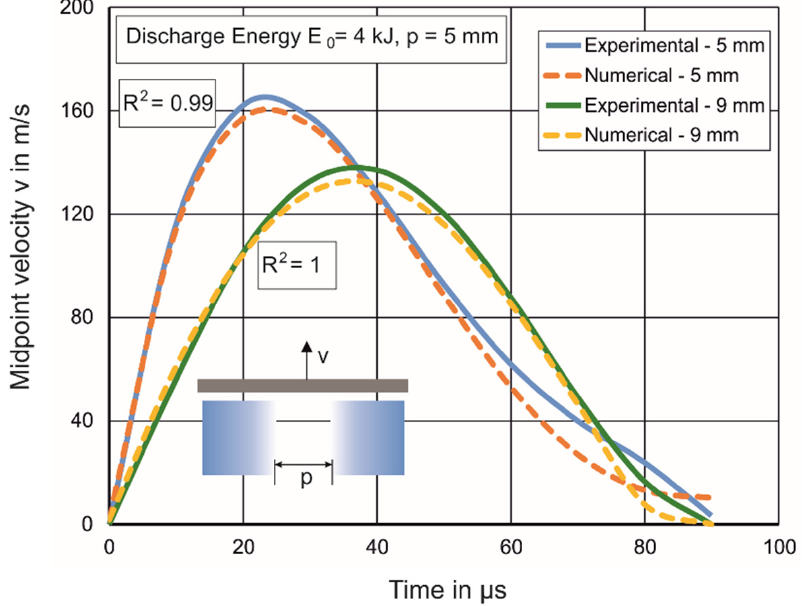
Figure 11. Comparison of the vertical velocity of the midpoint of the workpiece from numerical and experimental (PDV) analyses for two different spacings (p) between the coils.